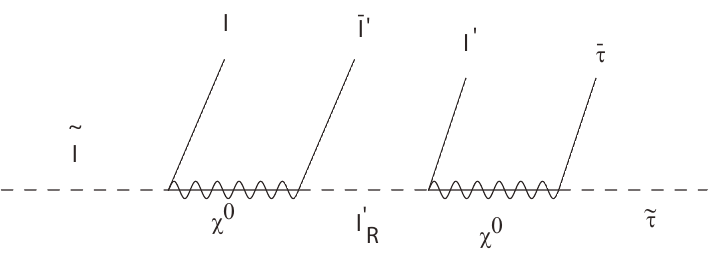
Figure 4 . Decay chain of left handed sleptons through right handed sleptons and stau